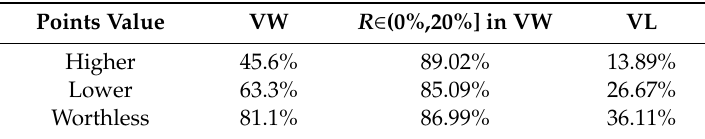
Table 1. Statistical table of survey of voting